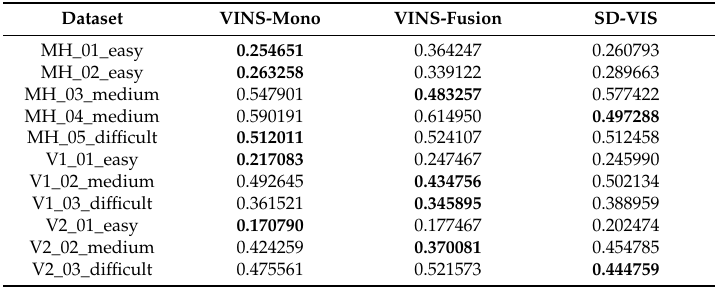
Table 1. The root mean square error (RMSE) results of the translation